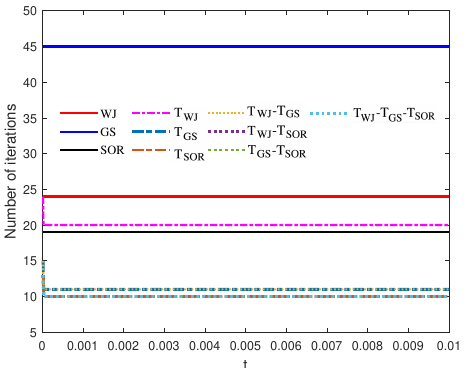
Figure 6. The evolution of the number of iterations for the WJ, GS, and SOR methods and the proposed methods in solving the problem (20) with 101 nodes and t ∈ ( 0,1 ]